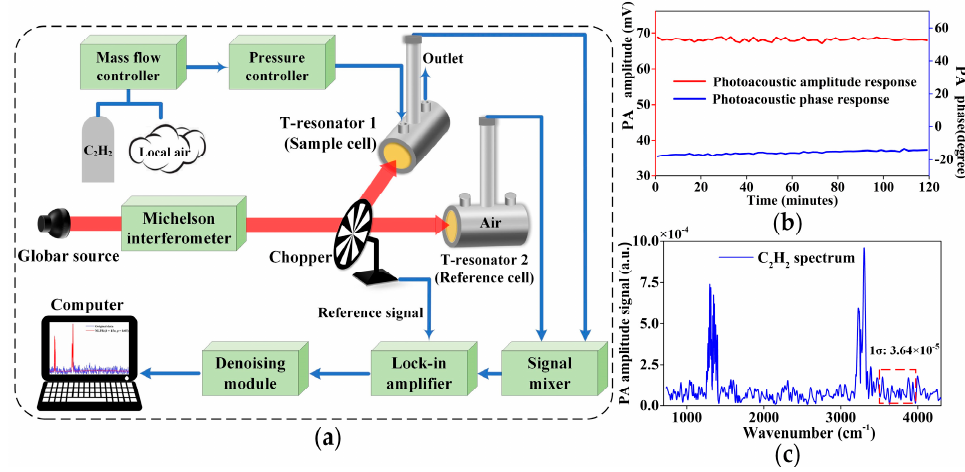
Figure 1. ( a ) Schematic of NLPR denoising enhanced DFTIR − PAS trace gas sensor system; ( b ) time stability of the PAS − based gas sensor; ( c ) differential photoacoustic signal of 100 ppm C 2 H 2 based on DFTIR without